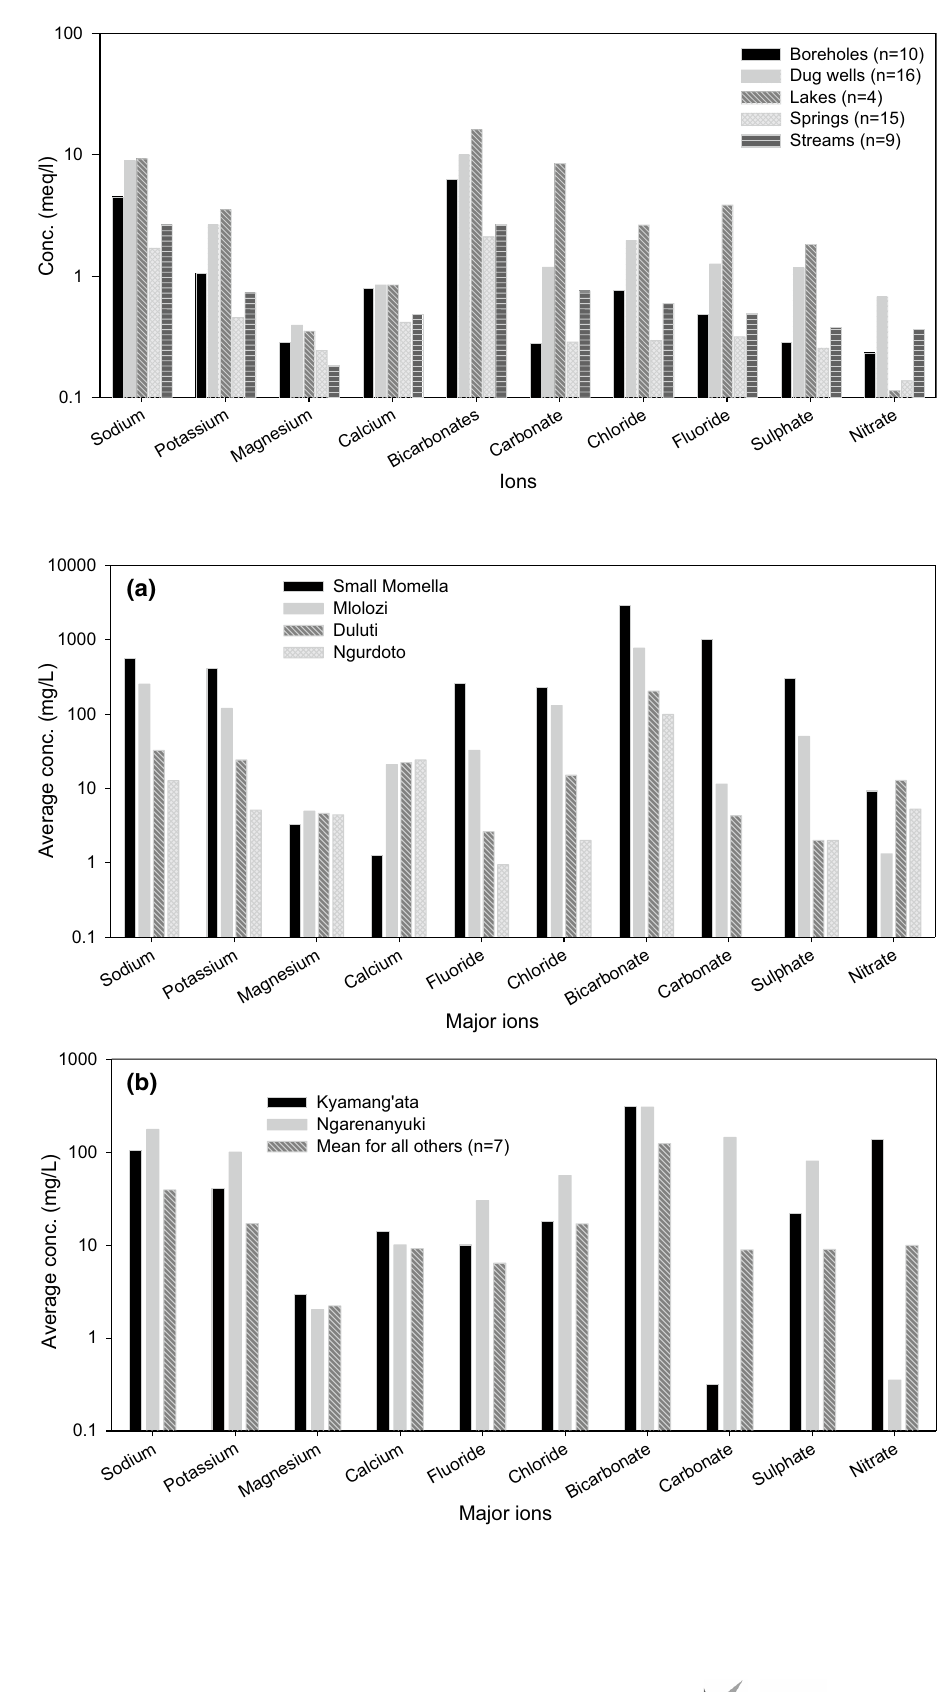
Fig. 13 Major ions average con- centrations for Meru water types